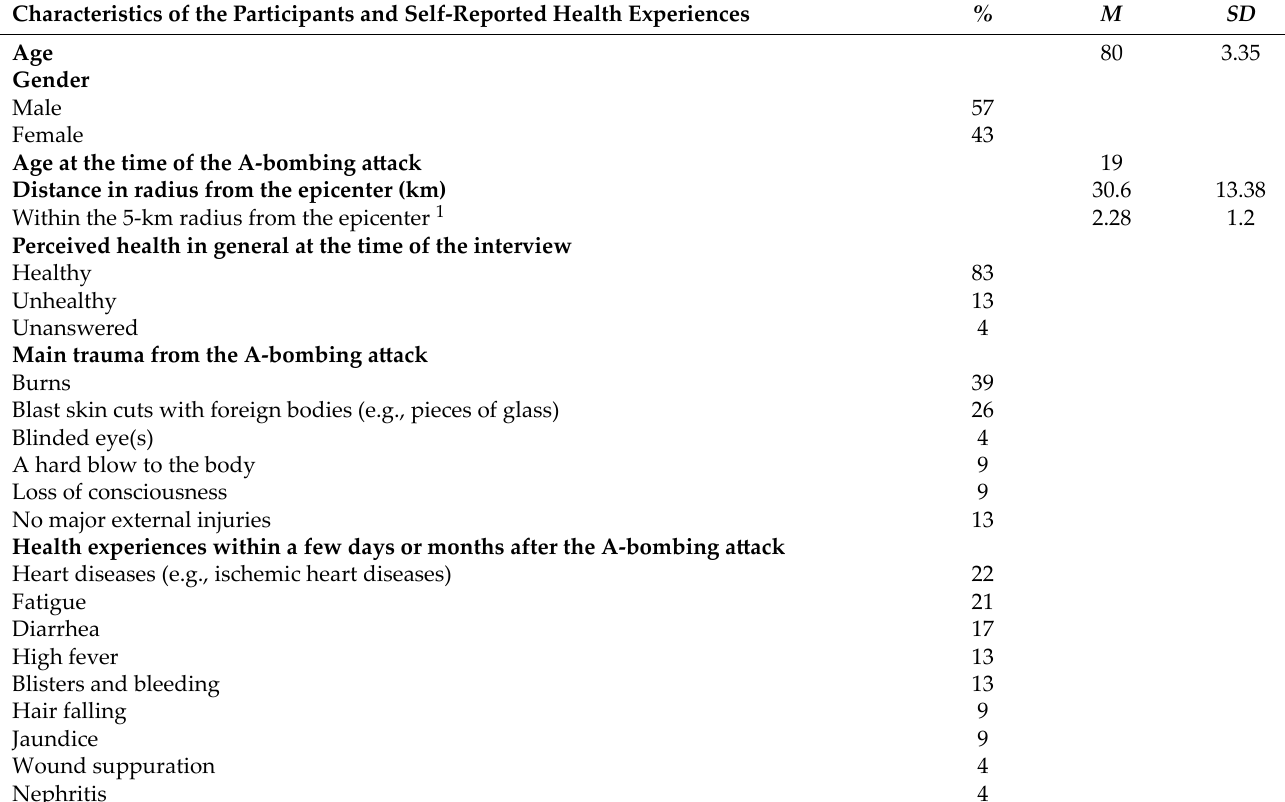
Table 2. Characteristics of the survivors’ self‑reported health experiences onwards from the Hi‑ roshima A‑bombing